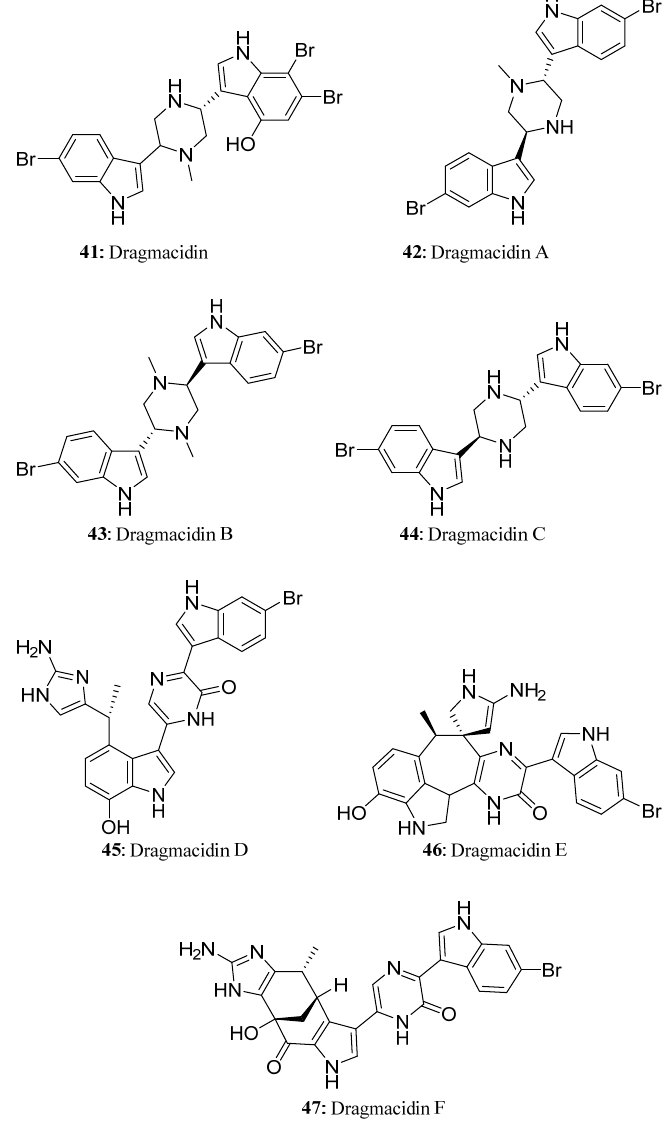
Figure 9. Structures of dragmacidin and dragmacidin A–F ( 41 – 47 ). Due to their wide range of both biological and pharmacological activities, the neces- sity of the total synthesis is obvious. Jiang and co-workers reported the total synthesis of compound 41 [42] (Scheme 5). In the same year, Cava and co-workers reported a simple synthesis of compound 43 [43]. A short synthetic strategy for various bis-indole marine natural products, including compound 43, was described by Horne [44]. The first total synthesis of racemic compound 42 via indolyl glycines was accomplished by Kawasaki and co-workers, and the method could be applicable to the syntheses of other members of the dragmacidin family and analogues [45]. In 2005, the facile formal total synthesis of compounds 43 and 44 was reported [46]. The chiral bis-indole alkaloid compound 41 was reported to inhibit in vitro growth of P388 murine leukemia cells (IC 50 = 15 μ g/mL). Addi- tionally, it inhibited the expansion of the cancer cell lines A-549 (human lung), HCT-6 (human colon), and MDAMB (human mammary) (IC50 = 1–10 g/mL) [46]. Serine-threo- nine protein phosphatase inhibitors have been found as substance 46 and compound 45 , its cometabolite [47].